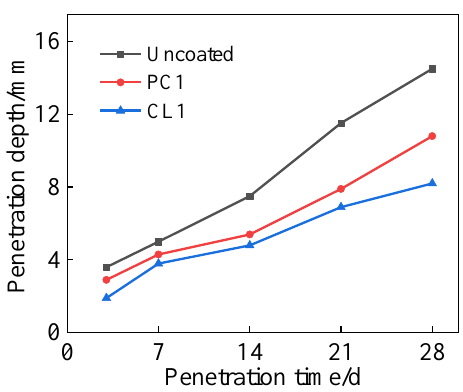
Figure 5. Impact of the coatings on chlorideion penetration depth of specimens.